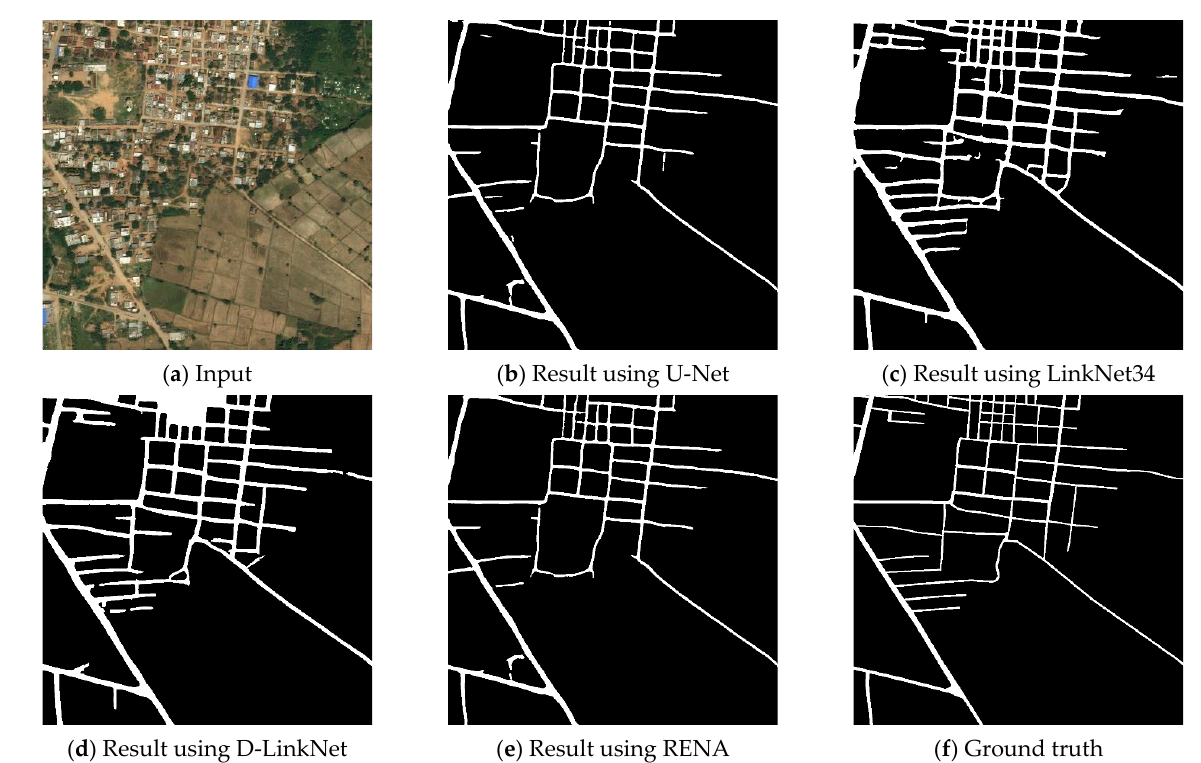
Figure 8. Visual evaluation results of the third group of dense road networks.